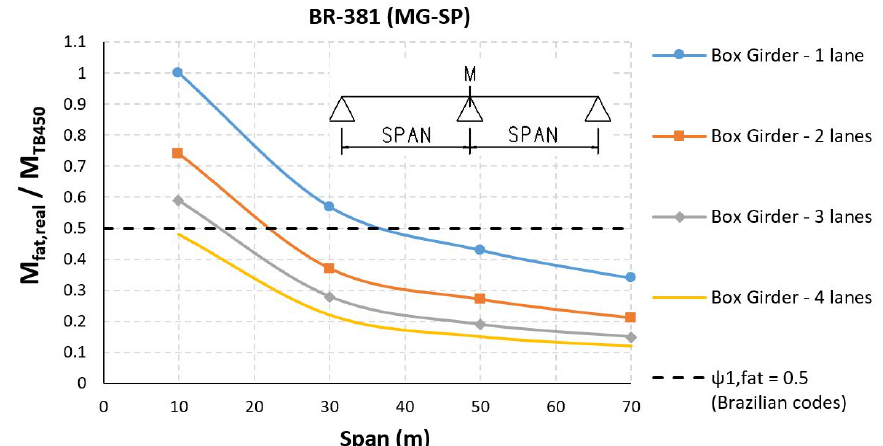
Figure 15. Bias factors for bending moment at support in continuous box-girder bridges – BR-381